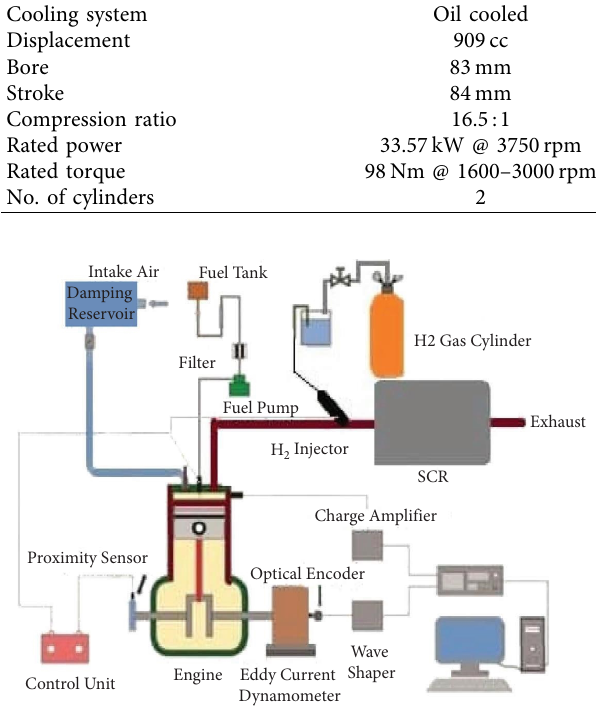
Figure 1: Engine setup with